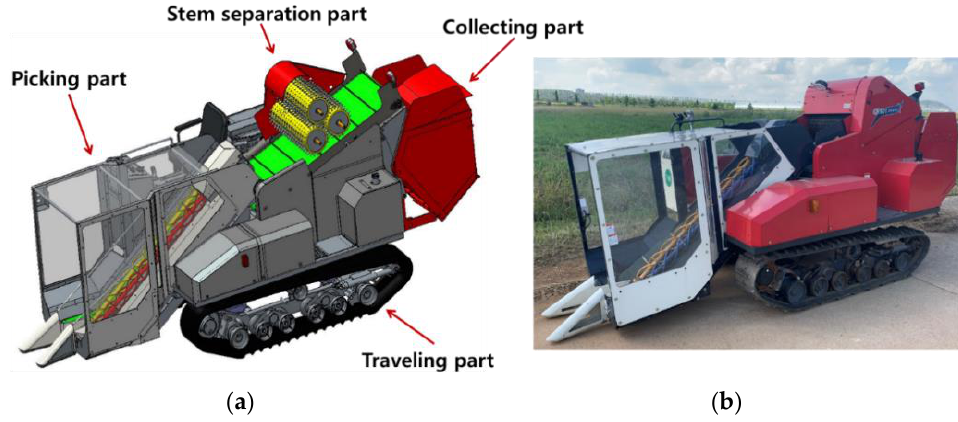
Figure 1. 3D design ( a ) and picture ( b ) of the prototype pepper harvester. Table 1. Specifications of the mid-size chili pepper harvester. Table 1. Specifications of the mid-size chili pepper